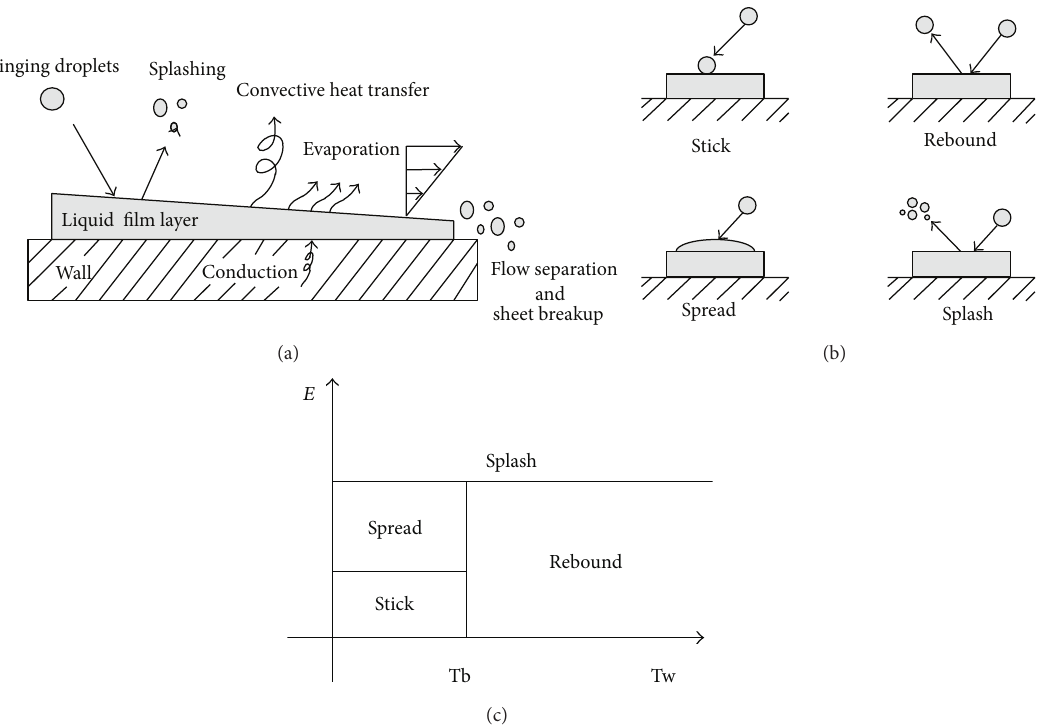
Figure 2: (a) Mechanisms of mass, momentum, and energy transfers for the wall-film model; (b) the four impingement regimes included in the model; (c) simplified decision for wall interaction